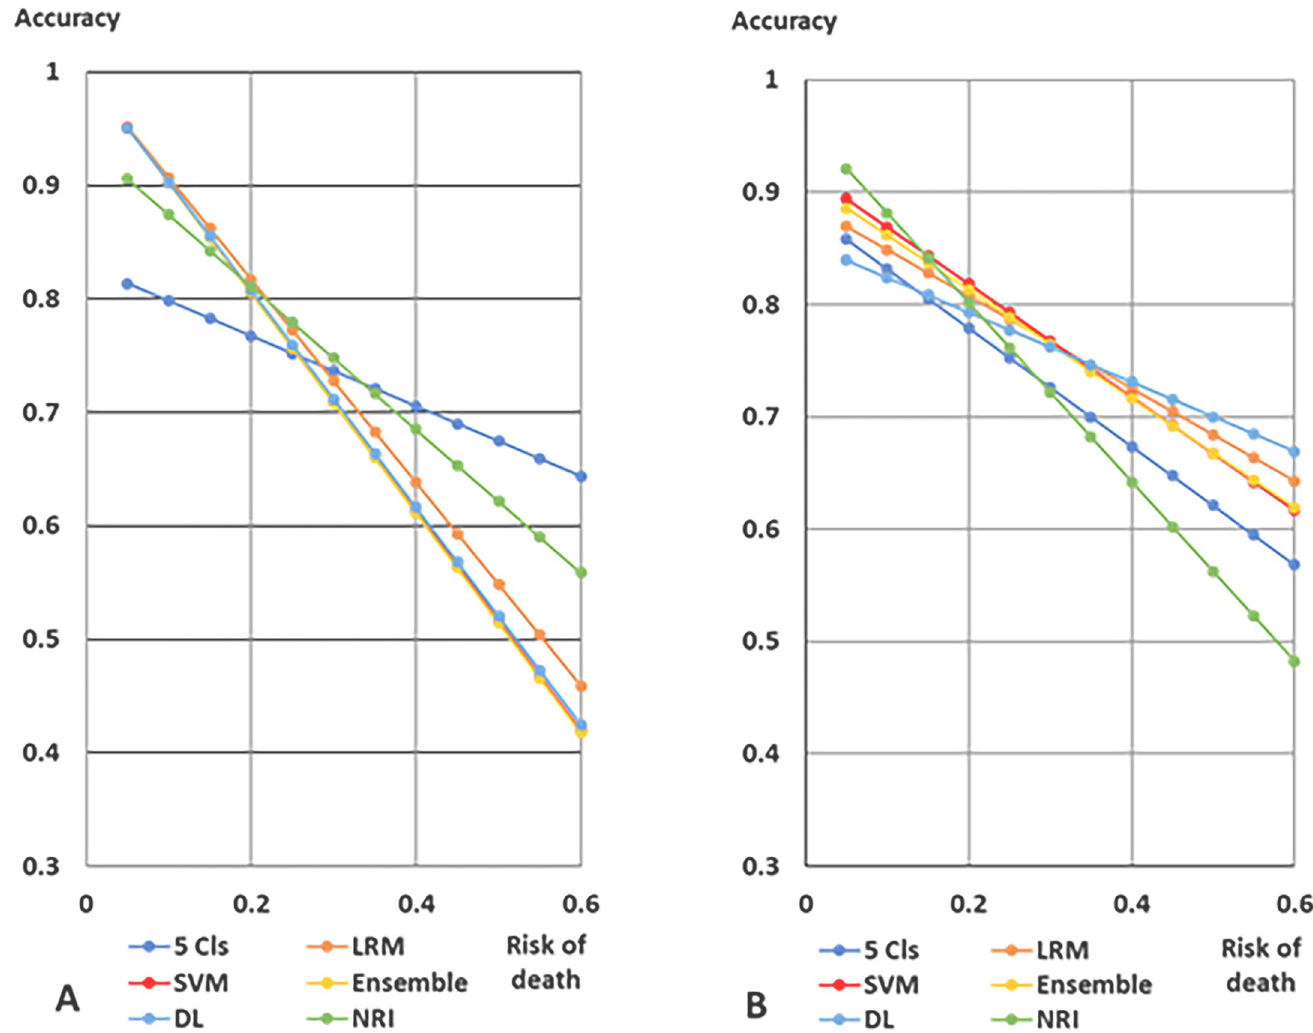
Fig 10. Accuracies and risk of 1-year and 5-year deaths. A. 1-year death. B. 5-year death. The accuracies of the model were calculated at 1year and 5-year death. Abbreviations: 5 Cls, the cutoff point was the fourth cluster of clusters; LRM, multivariate logistic regression model; SVM, support vector machine; ensemble, ensemble model of K-means method and SVM models; DL, deep learning model; NRI, nutritional risk